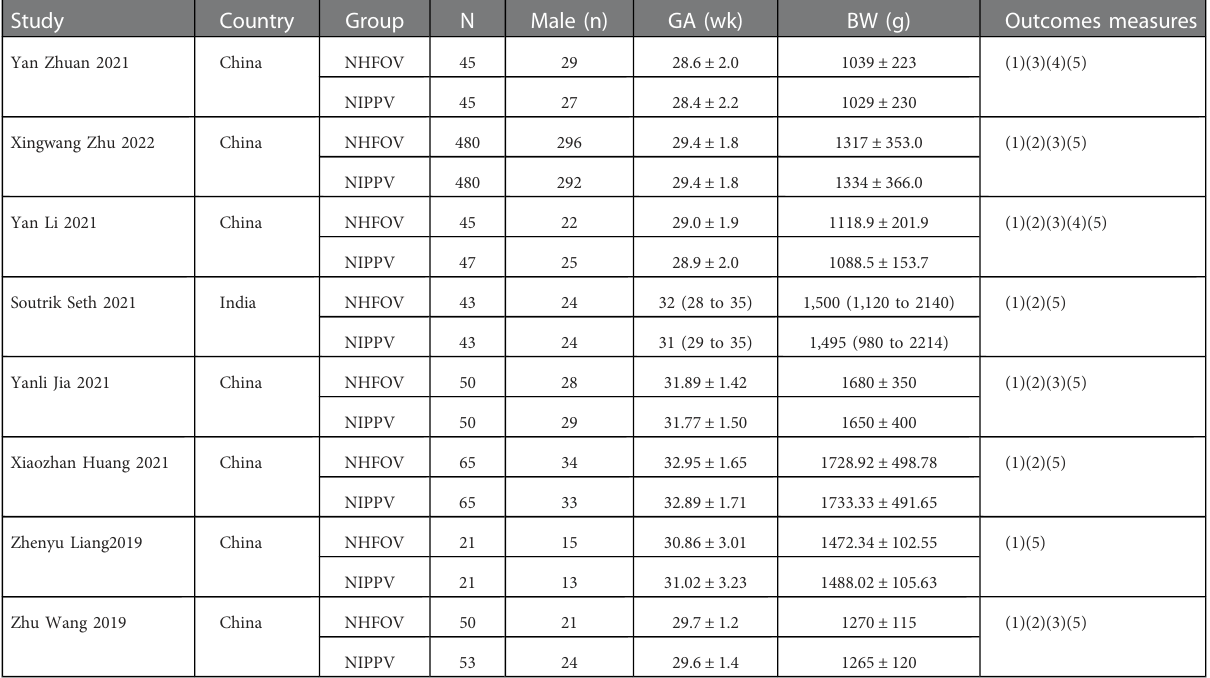
TABLE 1 Characteristics of the 8 included trials that compared NHFOV with NIPPV. Study